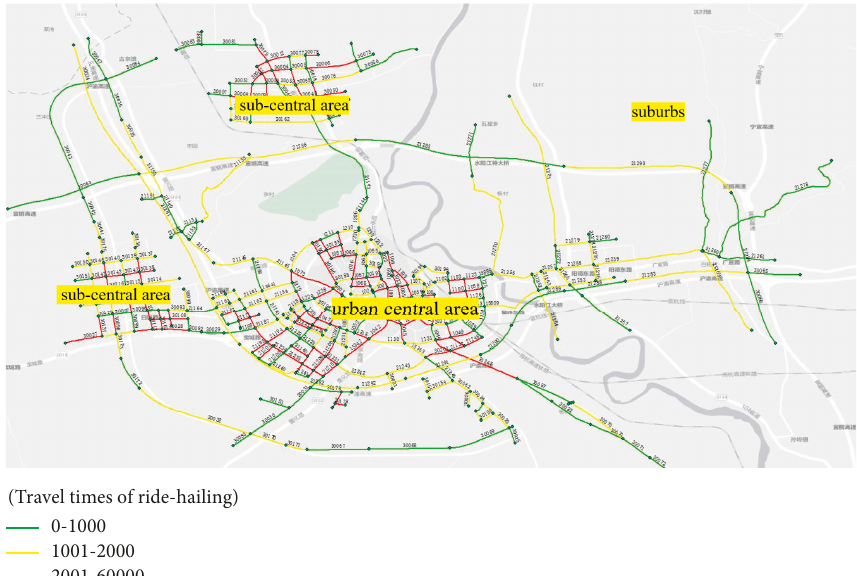
Figure 5: Data distribution of travel times of ride-hailing vehicles in each area of Xuancheng.